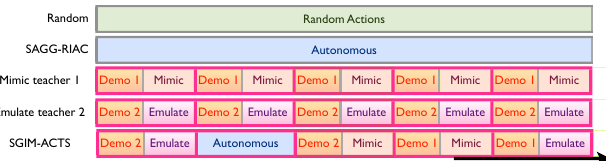
Figure 5. Comparison of several learning algorithms